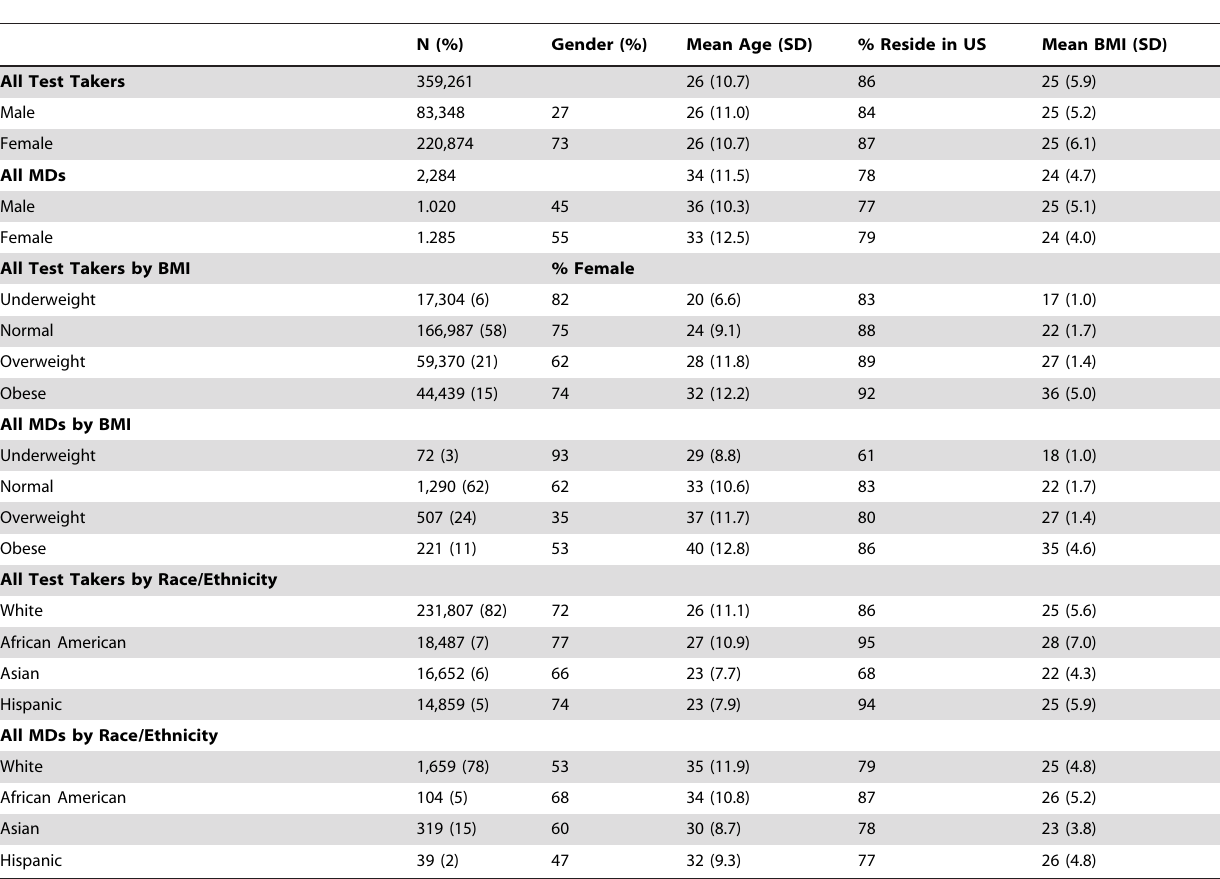
Table 1. Characteristics of Weight IAT Test-taker